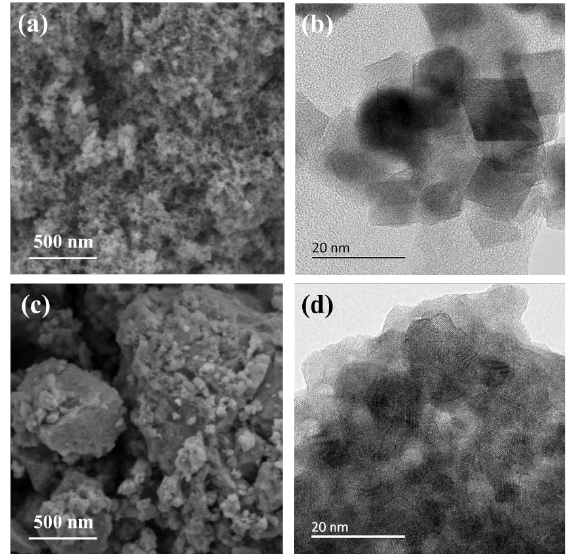
Figure 4. Morphology of materials: SEM ( a , c ) and TEM ( b , d ) micrographs of FSP-CuCe(10) ( a , b ) and CP-CuCe(10) ( c , d ) catalysts.